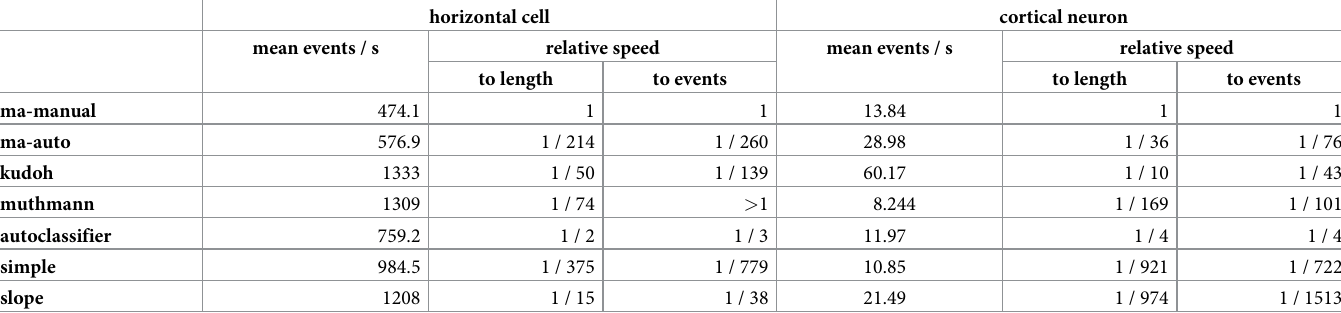
Table 1. Table showing the mean number of events and the relative speed of the specified algorithms normalized to “ma-manual”